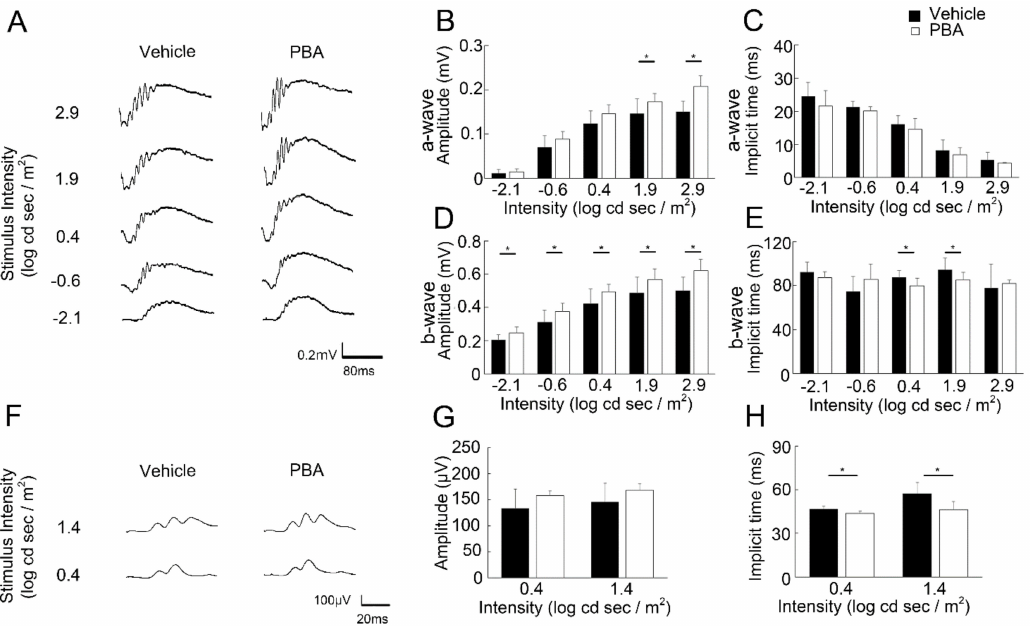
Figure 2. Preservation of visual function by PBA in the P23H RP models ( A – H ) ERG recorded at 10 weeks of age. ( A ) Representative wave forms of scotopic ERG from individual mice at a stimulus intensity from − 2.1 to 2.9 log cd s/m 2 in the P23H RP models with or without PBA treatment. Amplitudes of a-waves representing rod photoreceptor function ( B ) and amplitudes ( D ) and implicit times ( E ) of b-waves representing subsequent retinal cell function showed that PBA played a vision-protective role in rod photoreceptors. Representative wave forms of photopic ERG from individual mice at a stimulus intensity of 0.4 and 1.4 log cd s/m 2 ( F ) showed that implicit time of b-wave representing cone photoreceptor function was preserved by PBA treatment ( H ). ERG, electroretinography. Data are shown as mean ± standard deviation. ( A – E ) n = 10–11. ( F – H ) n = 5–6. * p <